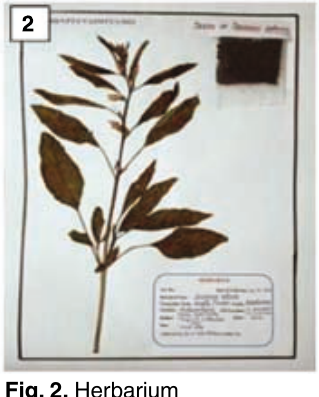
Fig. 1. Seeds of Sesamum indicum